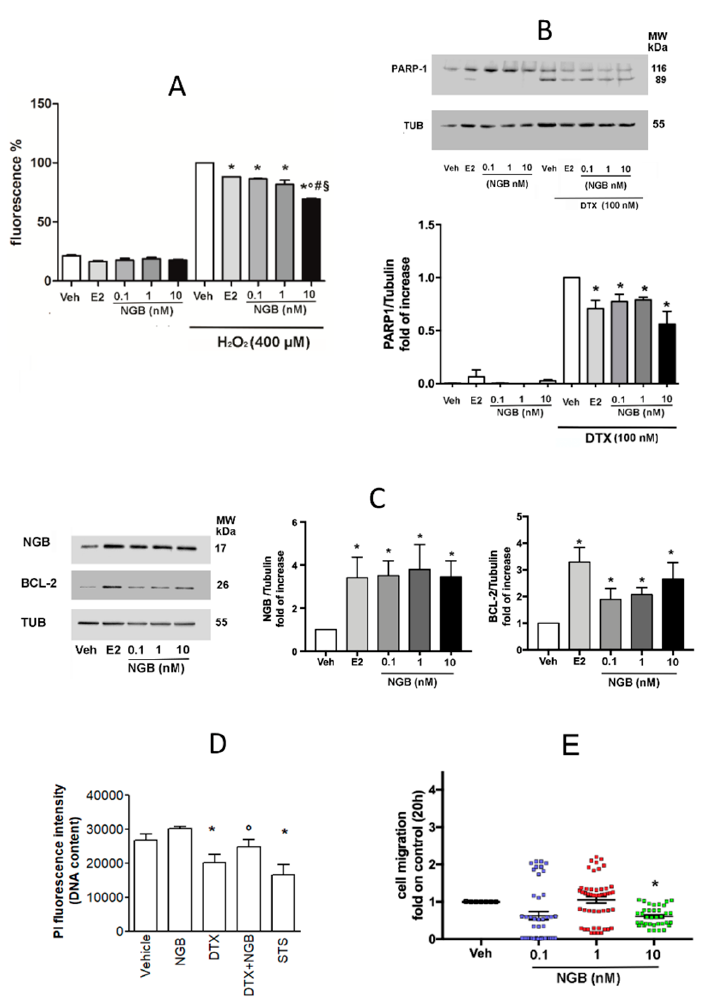
Figure 3. E ff ects of exogenous NGB on MCF-7 cell phenotype. ( A ) Reactive oxygen species (ROS) generation in MCF-7 cells pretreated with vehicle (EtOH / PBS 1 / 10 v / v ), E2 (10 nM), or exogenous NGB (0.1, 1, and 10 nM) for 4 h and then exposed to H 2 O 2 (400 µ M; 30 min). Data are shown as percentage with respect to H 2 O 2 treatment alone (100%). ( B ) Western blot (upper panel) and densitometric analyses (bottom panel) of PARP-1 cleavage in MCF-7 stimulated with vehicle (EtOH / PBS 1 / 10 v / v ), E2 (10 nM) or exogenous NGB (0.1, 1, and 10 nM) (4 h) in presence or absence of following apoptotic stimulation with docetaxel (DTX; 100 nM; 48 h). ( C ) Representative Western blot (left) and densitometric analyses (right) of intracellular NGB and Bcl-2 protein levels in MCF-7 cells treated with vehicle (EtOH / PBS 1 / 10 v / v ), E2 (10 nM) or exogenous NGB (0.1, 1, and 10 nM) for 48 h. The amount of protein was normalized by comparison with tubulin levels. ( D ) Analyses of MCF-7 cell DNA content obtained from propidium iodine assay (PI). Cells were stimulated with vehicle (EtOH / PBS 1 / 10 v / v ) and exogenous NGB (10 nM) (4 h) in presence or absence of following apoptotic stimulation with docetaxel (DTX; 100 nM; 48 h). Data are means ± SD of at least three di ff erent experiments. p < 0.01 was determined with ANOVA followed by Tukey-Kramer post-test vs. Vehicle (*) or docetaxel ( ◦ ) treatment. ( E ) Cell migration analysis of MCF-7 treated with vehicle (EtOH / PBS 1 / 10 v / v ) or NGB (0.1, 1, and 10 nM) for 20 h. Data are means ± SD of at least three di ff erent experiments. p < 0.01 was determined with ANOVA followed by Tukey–Kramer post-test vs. Veh-H 2 O 2 condition (*), vs. E2-H 2 O 2 condition ( ◦ ), vs. 0.1 nM NGB-H 2 O 2 condition (#), vs. 1 nM NGB-H 2 O 2 condition (§) ( A ) or Student’s t -test vs. Veh-DTX condition (*) ( B ) or vs. Veh treatment (*) ( C , E ). The whole blot images can be found in Figure